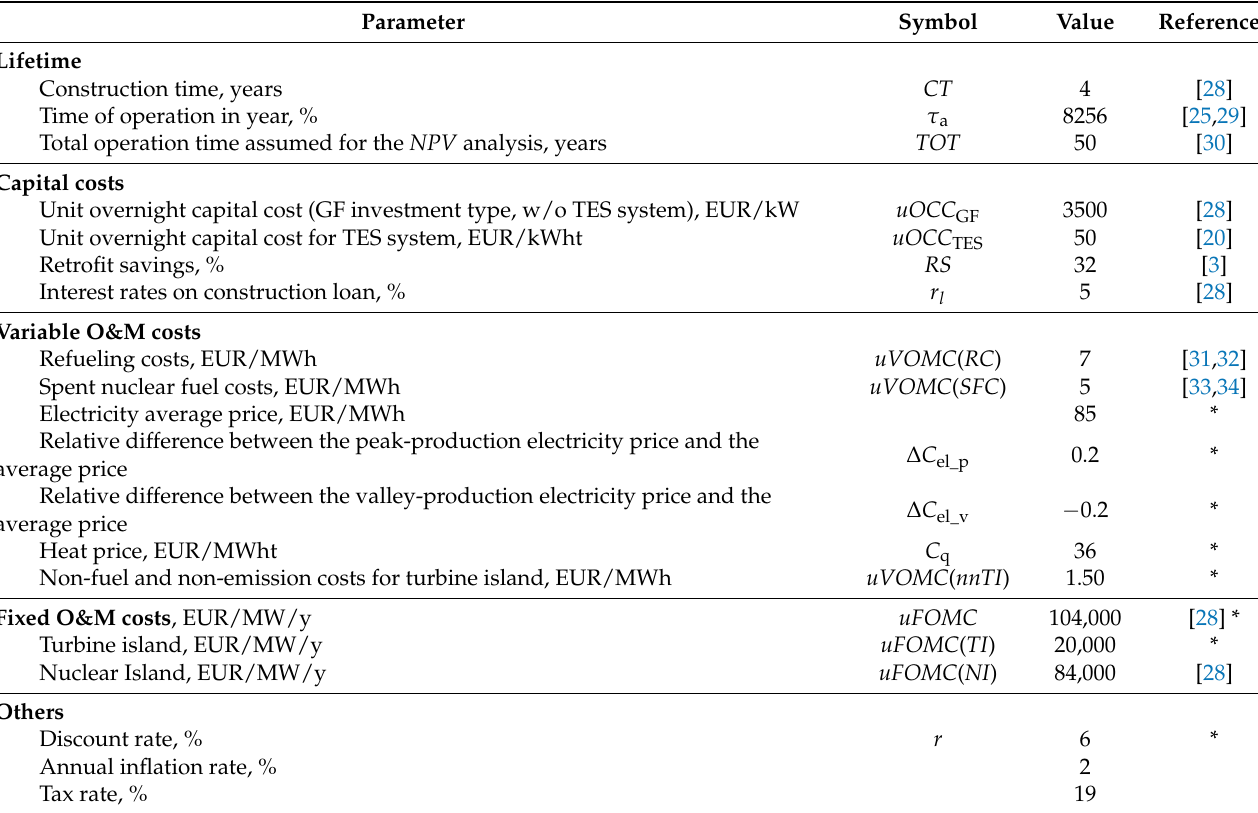
Table 2. Base economic parameter